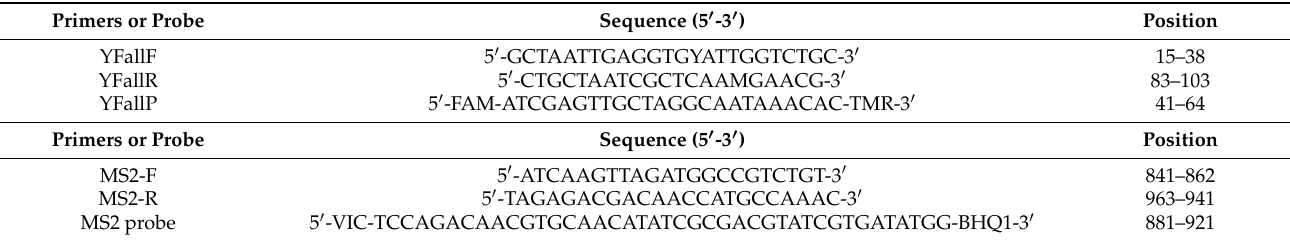
Table 2. Primers and probe used in the RT-qPCR technique for the detection of YFV and phage MS2.